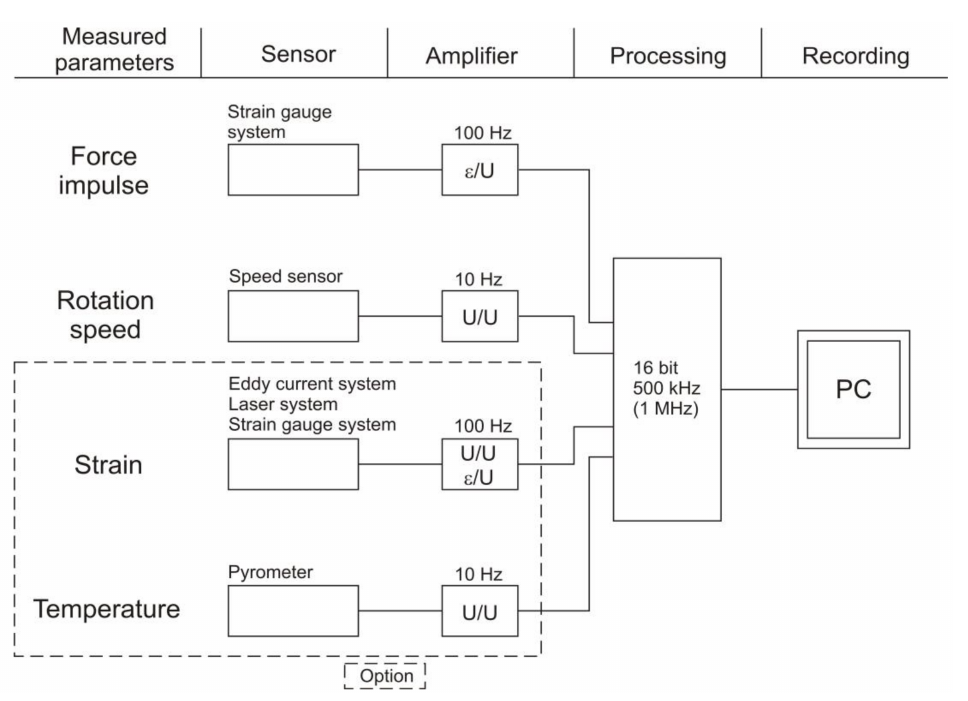
Figure 5. Diagram of the rotary hammer measuring system with the option of expanding the system. Temperature measurement is an essential issue in the optional scheme of the device due to the dynamic deformation in adiabatic conditions, without heat transfer with the environment. Knowing the temperature increase of the material during deformation will allow a proper assessment of microstructural changes caused by high deformation